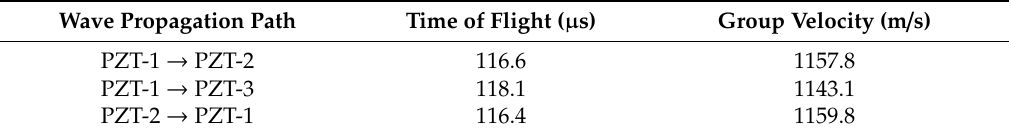
Table 2. Summary of wave propagation results including time of flight (ToF) and group velocity for waveform signals from bondline-embedded d15 and surface-mounted d31 PZT sensors at no-load